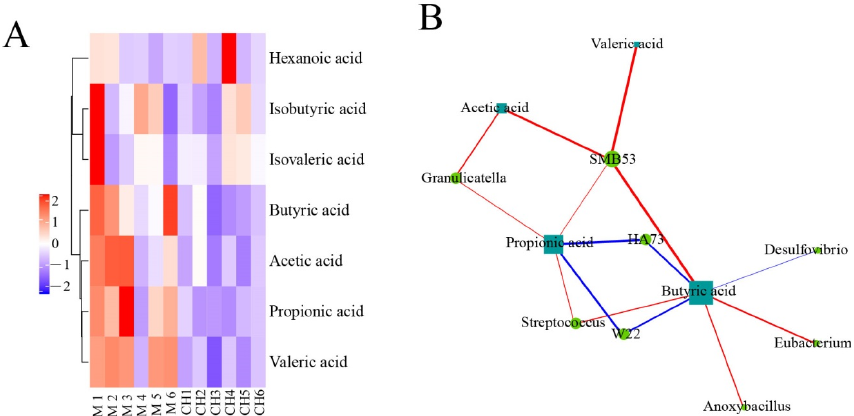
Figure 16. Correlation analysis of intestinal floras and SCFAs in chicken cecum contents between the model group and the intervention group of CASP. Note: ( A ) Cluster heatmap of SCFAs between the model group and the intervention group of CASP; ( B ) Network of intestinal floras and SCFAs between the model group and the intervention group of CASP.